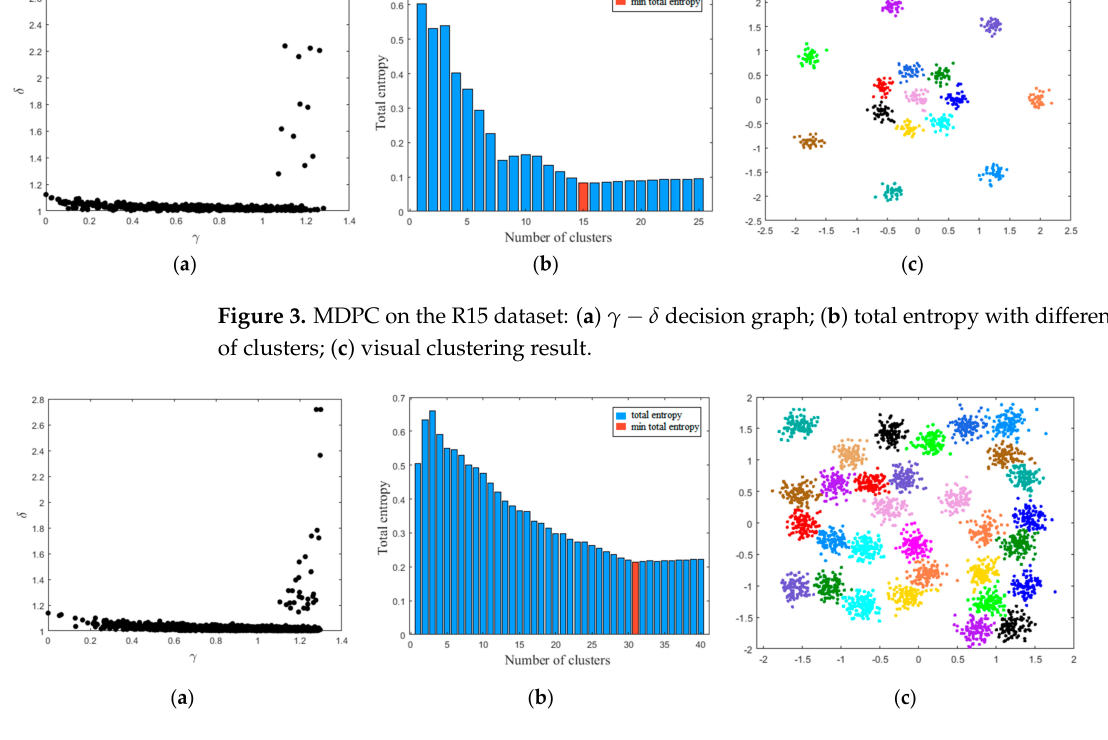
Figure 4. MDPC on the D31 dataset: ( a ) γ − δ decision graph; ( b ) total entropy with different number of clusters; ( c ) visual clustering result.